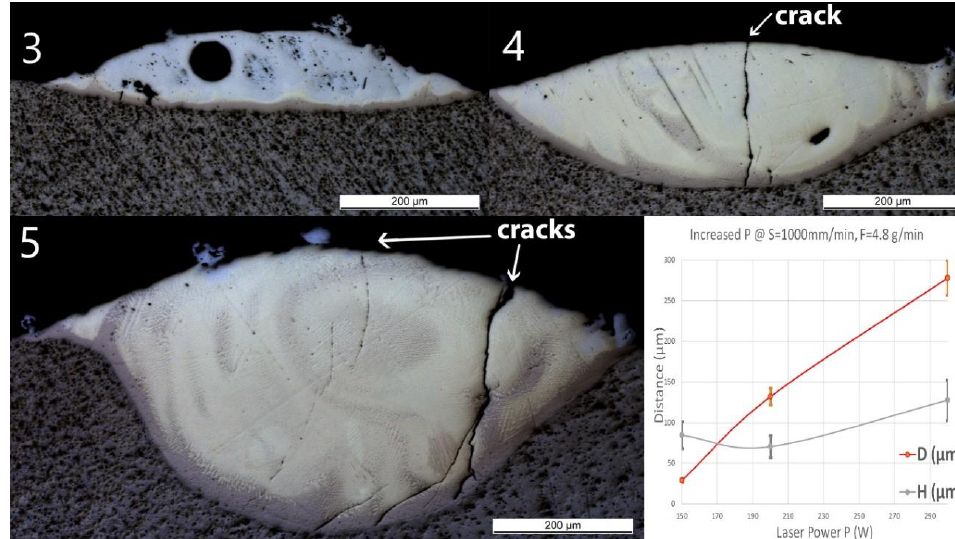
Figure 5. OM images of cross-sections of samples Line_P_3 to Line_P_5 (corresponding to the inserts 3 to 5 in the images above). The last diagram (bottom right) shows the influence of power (P) on penetration depth (D) and deposition height (H) of the tracks.